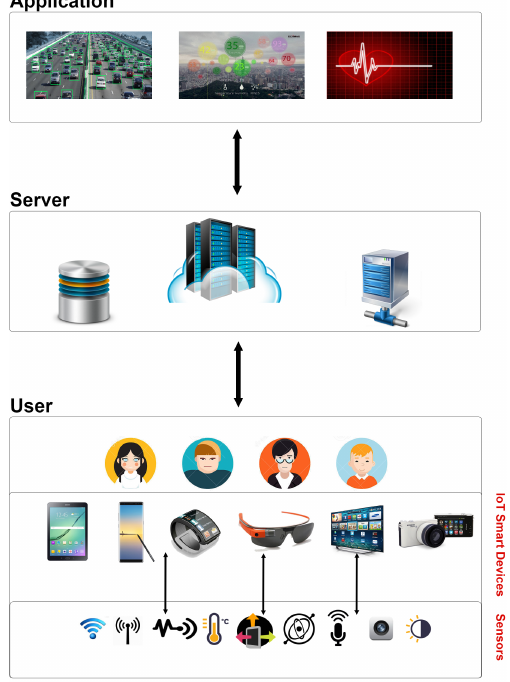
Figure 1. Building blocks of a typical Mobile Crowd-Sensing (MCS)